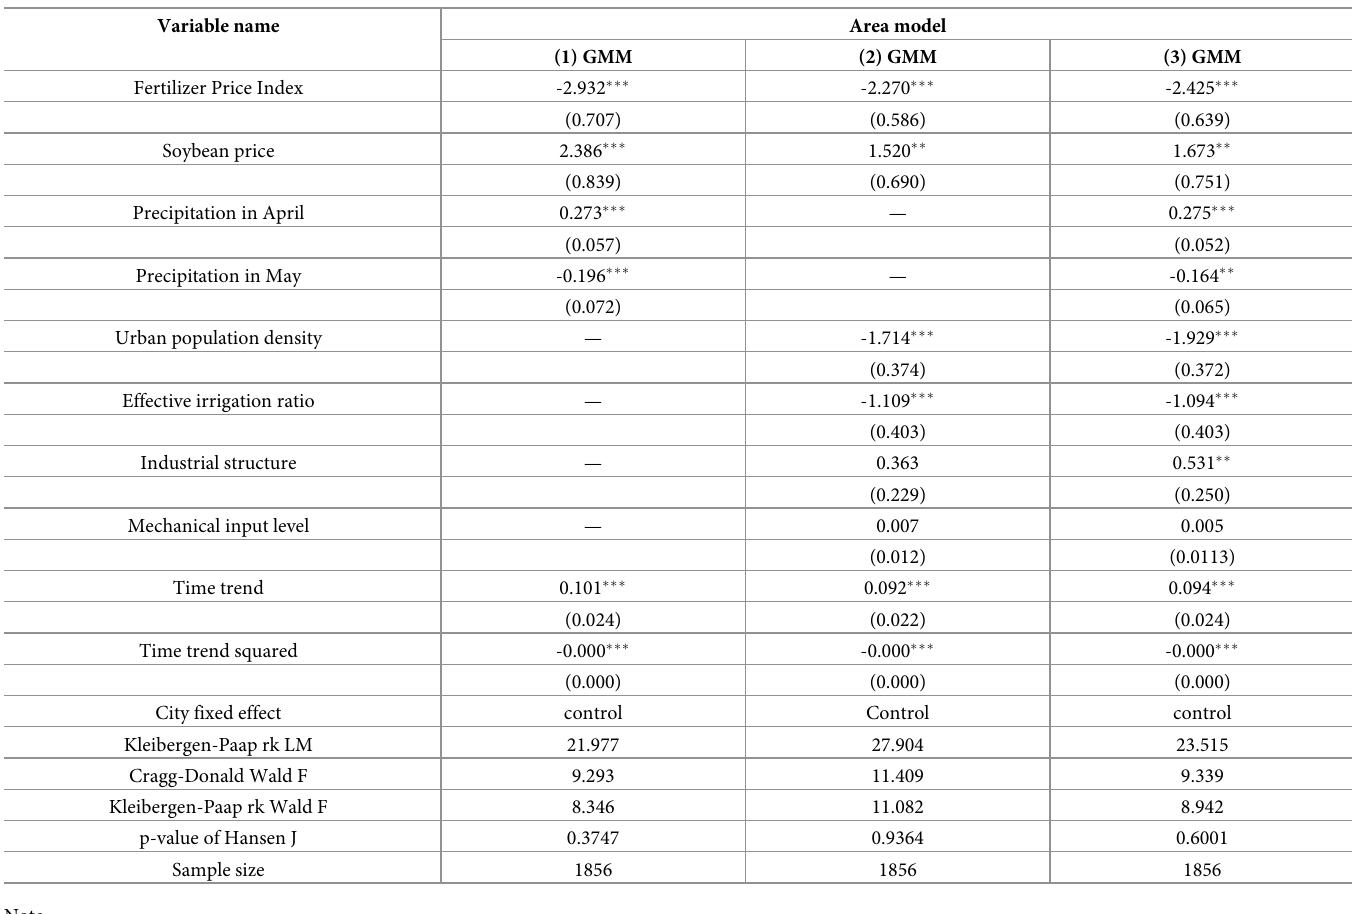
Table 4. The total soybean output is the regression result of the dependent